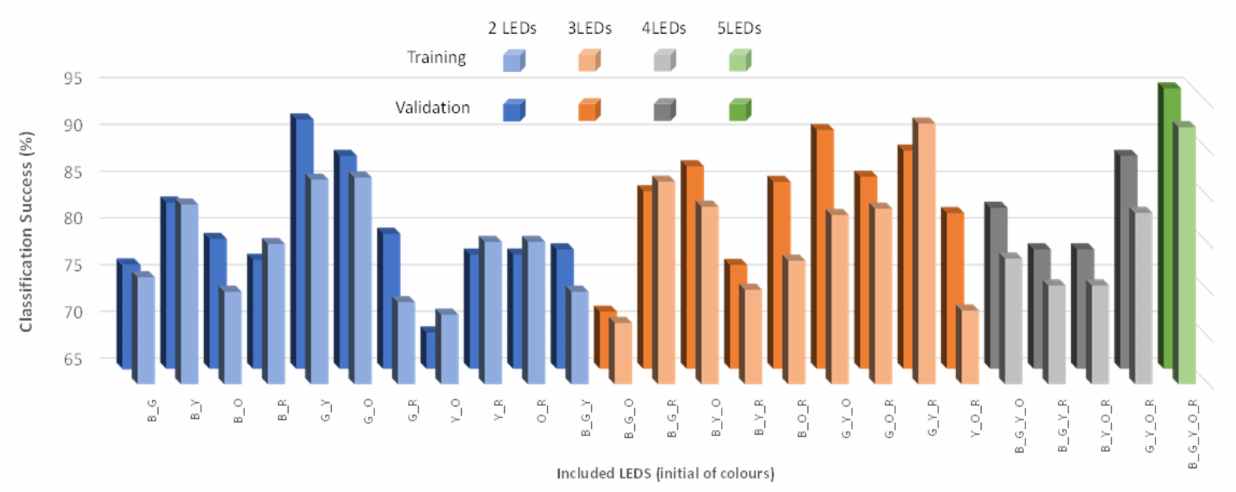
Figure 21. Training and validation of neural network.